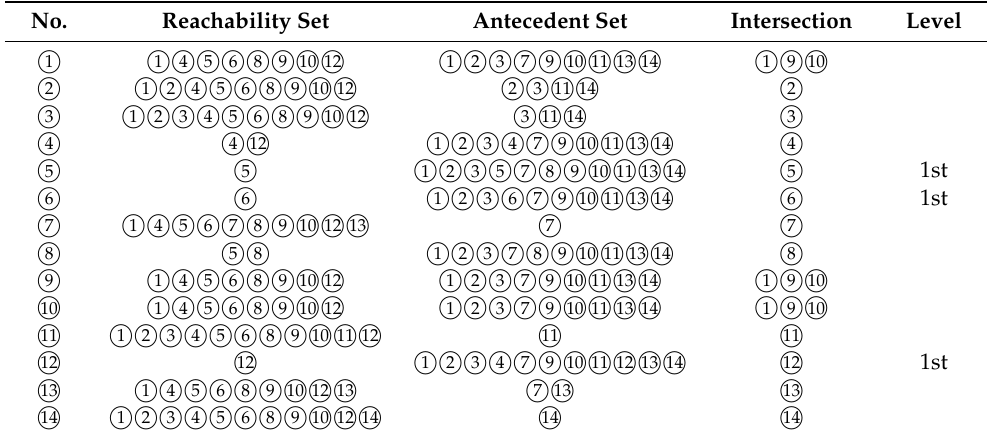
Table 6. Reachability set, antecedent set and intersection.